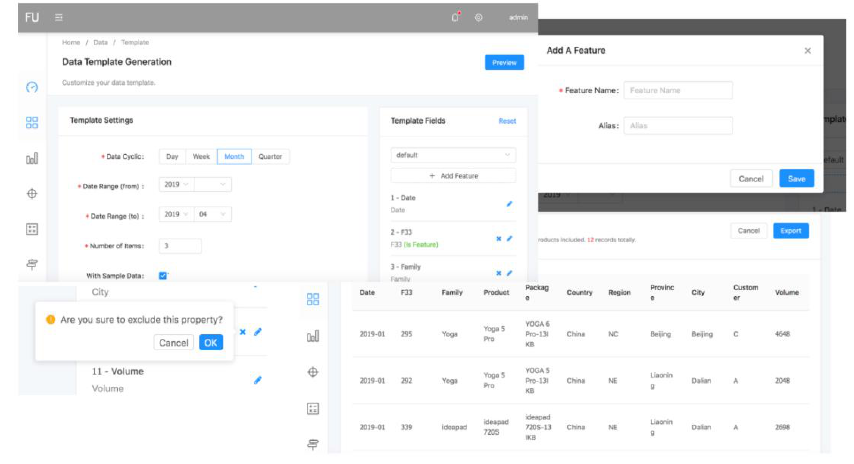
Figure A3. Data template generation page in Excel. To adapt to different preprocessing methods (e.g., one-hot encoding and normalization), we first determined the features template.